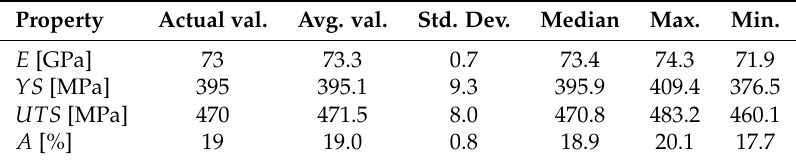
Table 7. Properties prediction for Al 2024-T4.